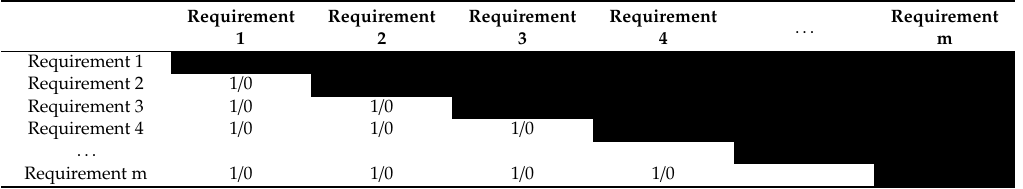
Table 6. Non-redundancy assessment matrix. The value “1” is introduced in those cells (in the lower triangle of the matrix) where a redundancy has been identified between the requirement in the row with the requirement in the column, i.e., when the share the same ENV